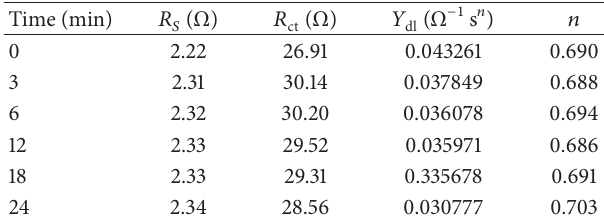
Table 3: Equivalent circuit parameters for effect of the addition of inhibitor B to base mixture.